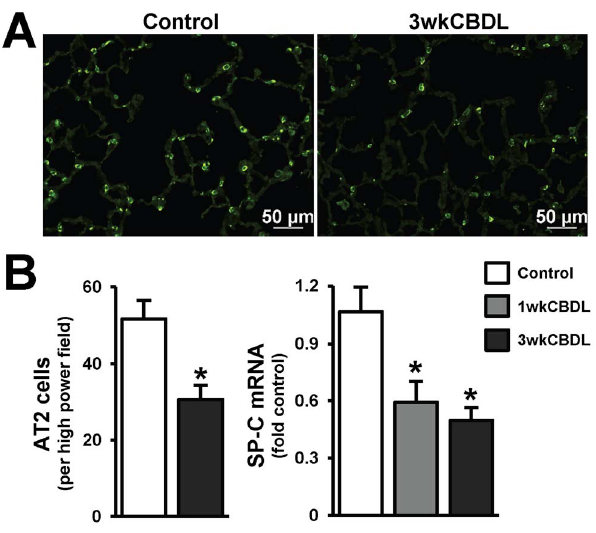
Figure 3. Alveolar type II epithelial cell (AT2) numbers and SP-C mRNA levels after CBDL. ( A ) Representative immunofluorescence images of SP-C staining in alveolar type II epithelial cell (AT2 cells, in green). ( B ) Quantitation of SP-C positive AT2 cells and pulmonary SP-C mRNA levels after CBDL by real-time RT-PCR. Cell counting was performed in a blinded fashion. CBDL resulted in decreased numbers of AT2 cells accompanied by reduced SP-C mRNA levels in lung. Scale bar 5 50 m m. Values are expressed as means ¡ SME. * P , 0.05 compared with